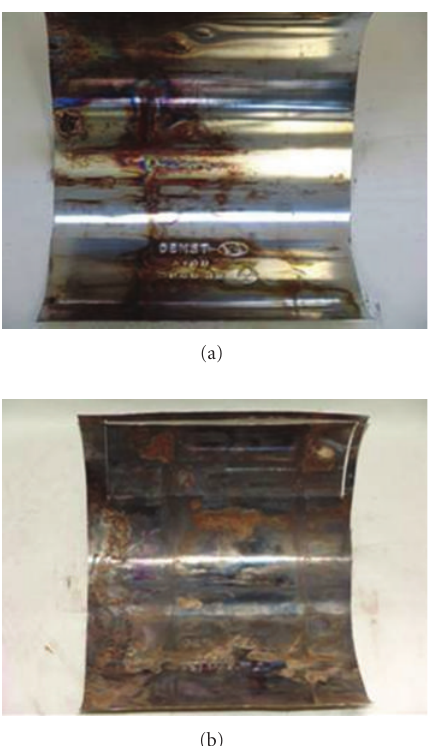
Figure 2: Comparison of field and tested system: (a) mu ffl er from field after 54878 km/6yrs and (b) mu ffl er after 6 weeks of testing. Figure 3: Comparison of field and tested system: (a) mu ffl er